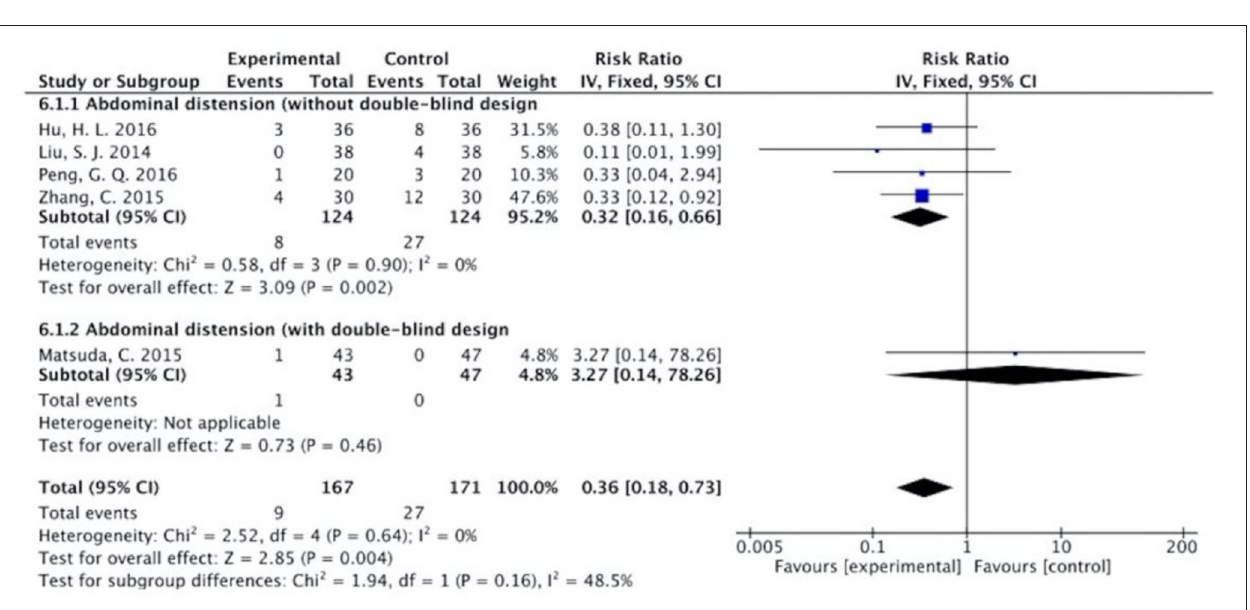
FIGURE 13 | Sub-analysis on the effect of herbal medicine in abdominal distension in chemotherapy-induced